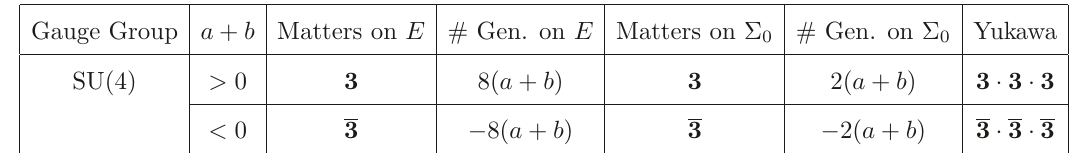
Table 5 . Potential matter spectra in F-theory compactification on (2,1,1,1) and (2,1,1,1) complete intersection (A.1) in P 3 × P 1 × P 1 × P 1